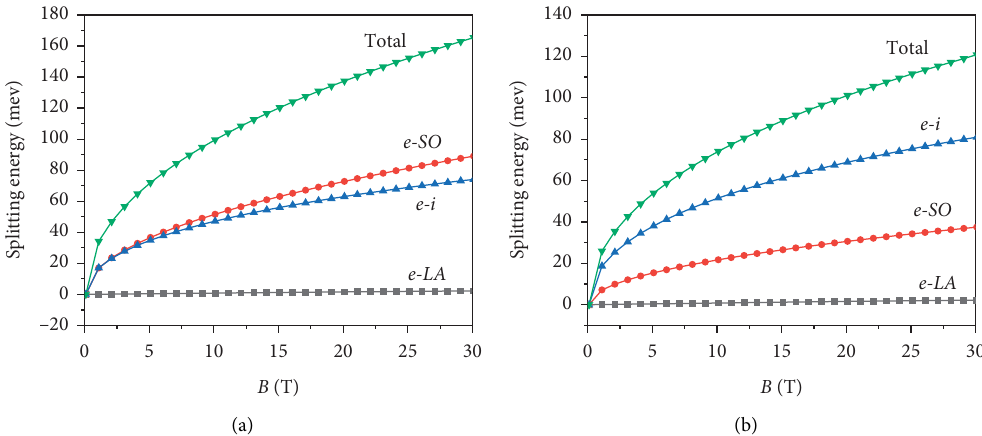
Figure 3: Relations between the splitting energy and magnetic field B for SiO